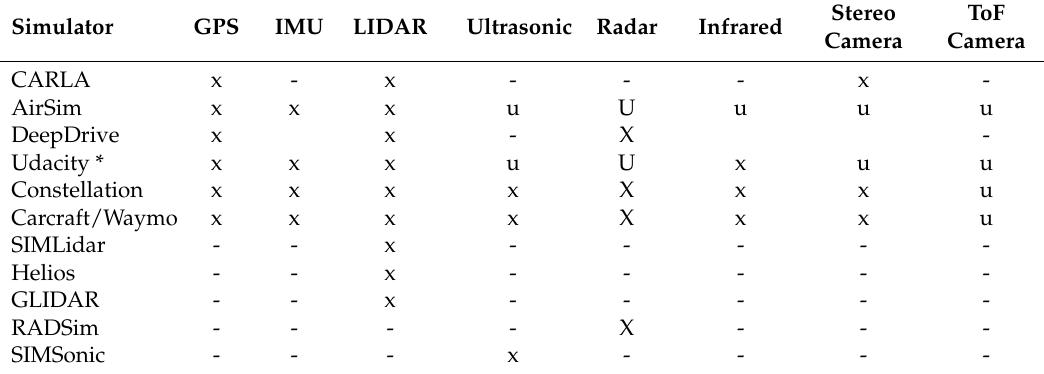
* Table Legend: x-Yes | u–Unknown or could not be determined | - –